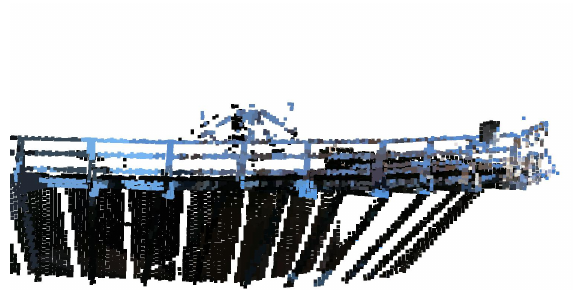
Figure 6: Leica C10 laser scanner point cloud colored using smartphone